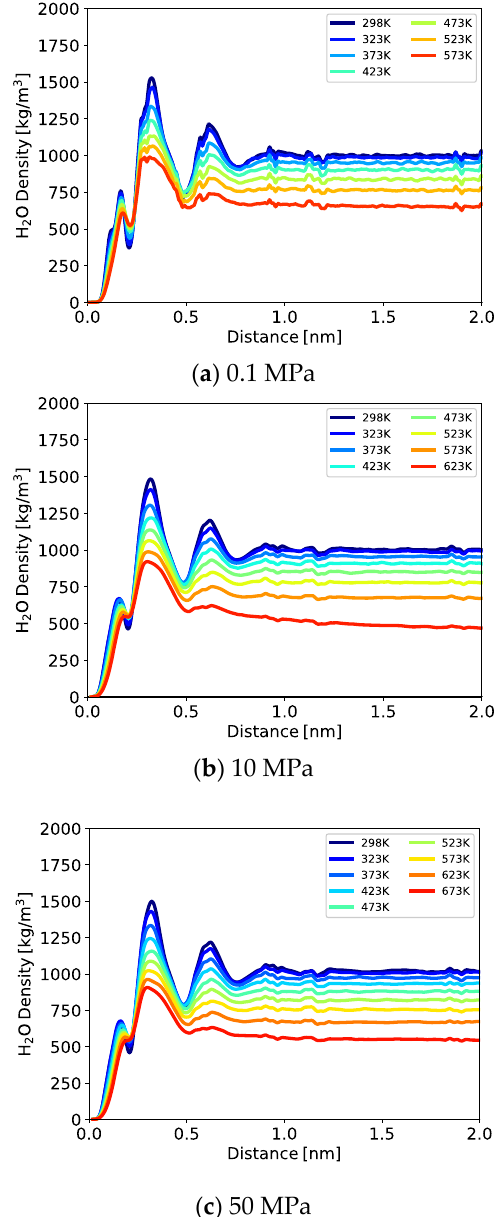
Figure 3. Density profiles of H 2 O molecules vs. distance from the muscovite surface.